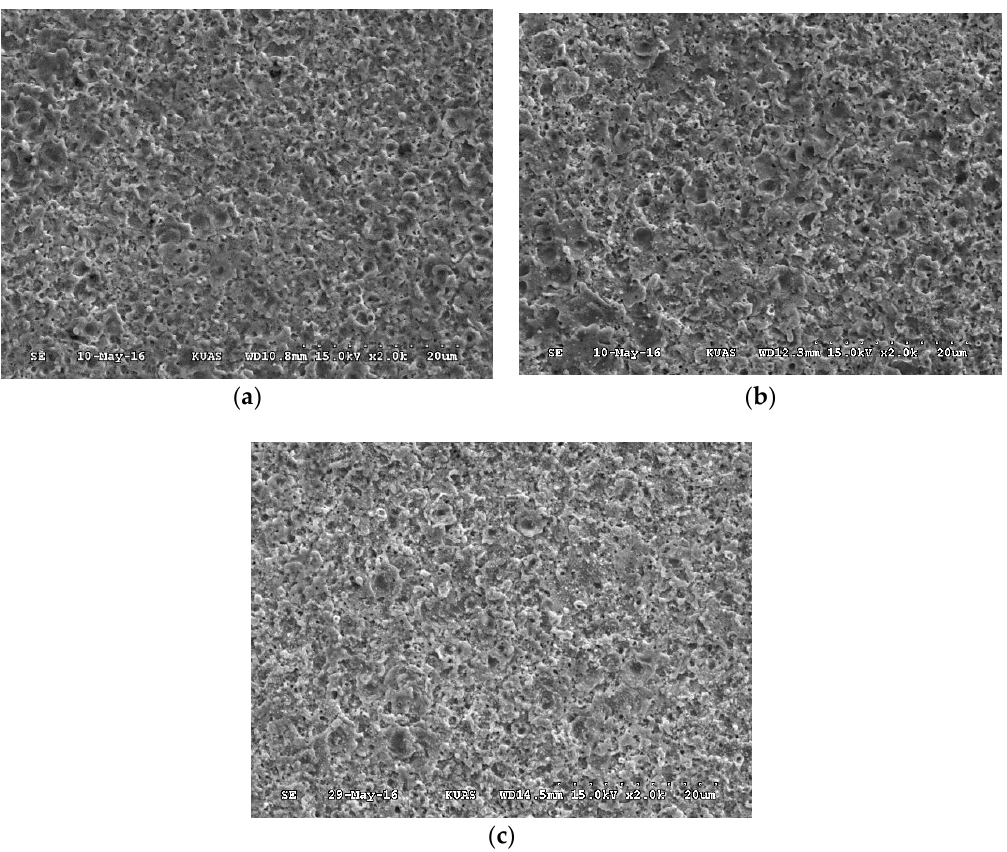
Figure 6. Surface appearance for different processing times with an AgNO 3 concentration of 0.03 wt.%: ( a ) 10 s; ( b ) 20 s; and ( c ) 30 s.